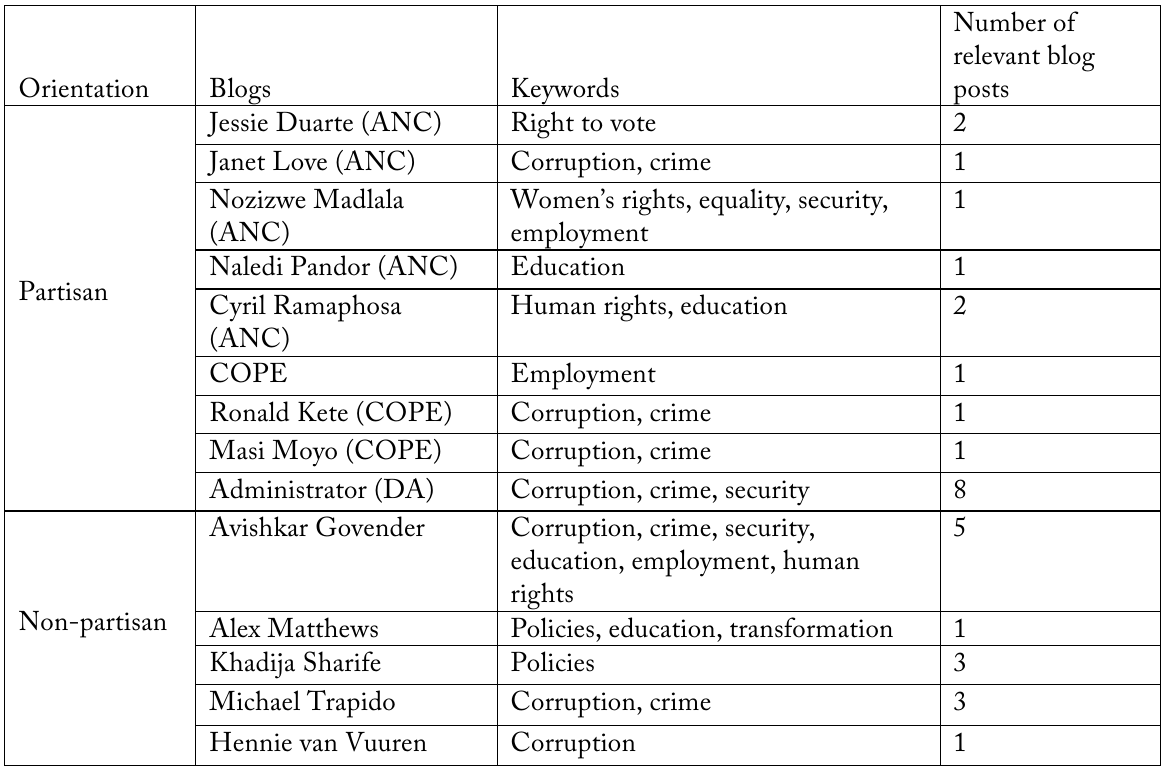
Table 3: Categorisation of the bloggers according to their political orientation and